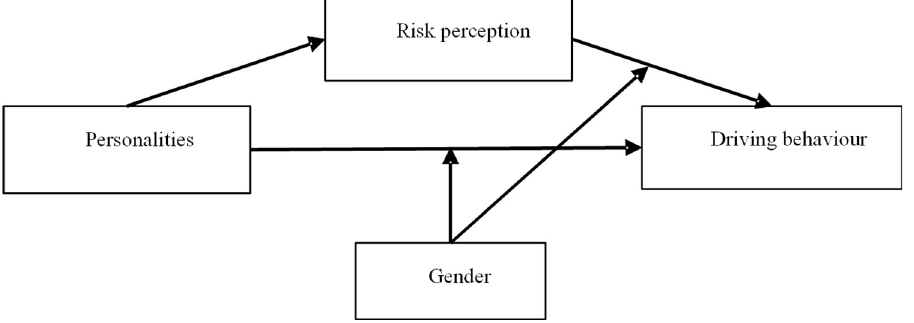
Fig 2. The proposed theoretical